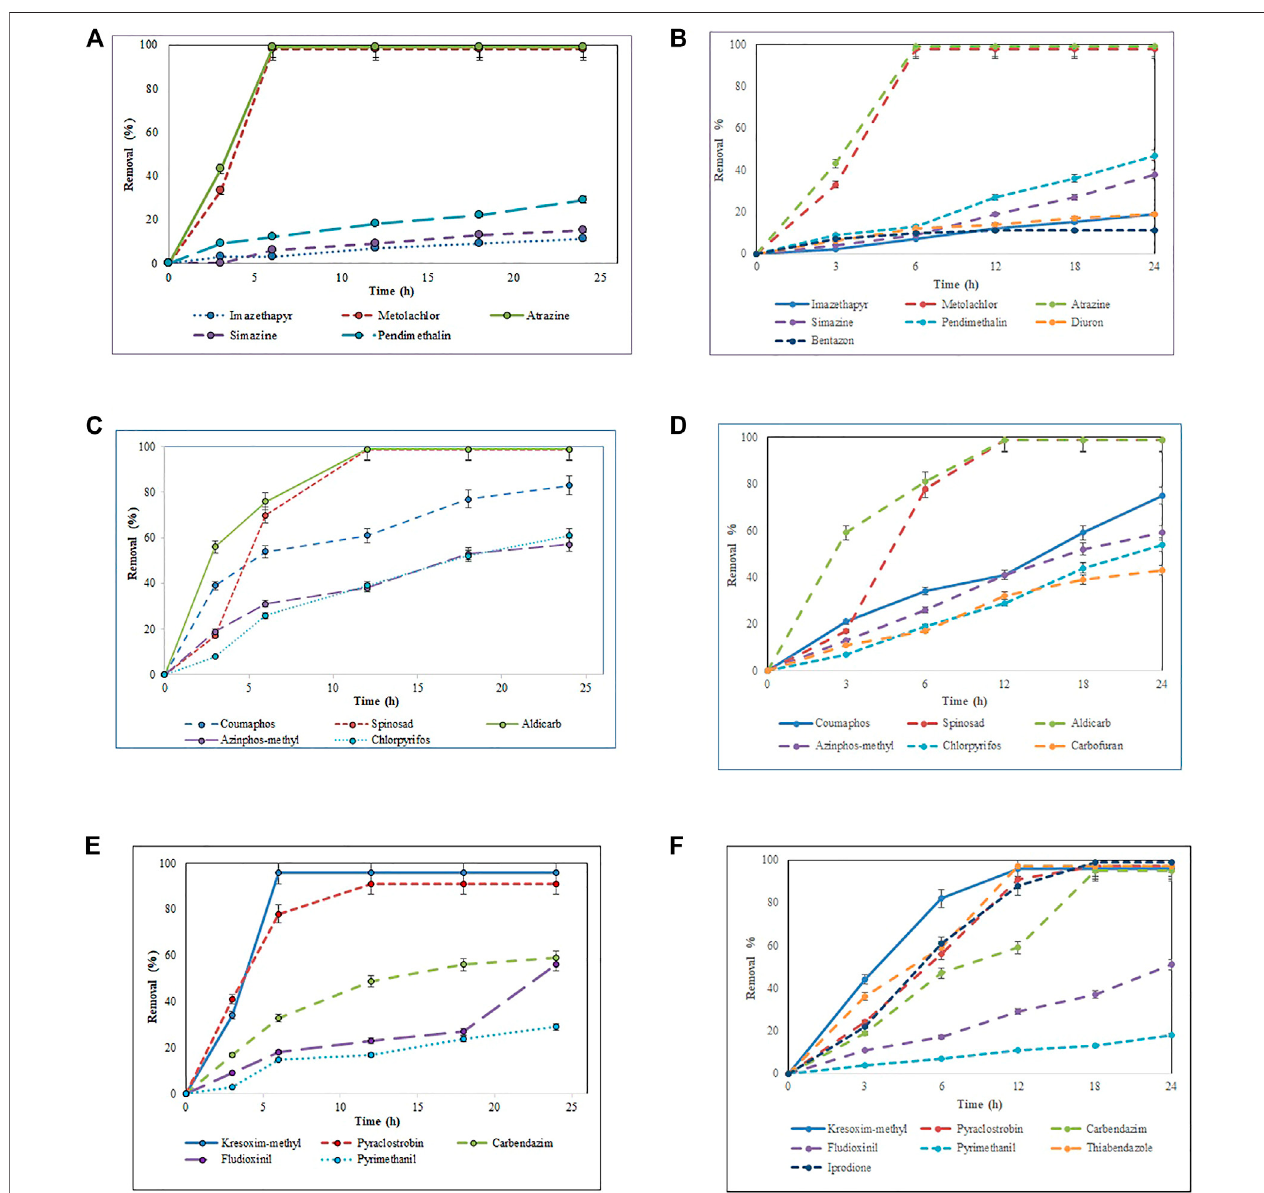
FIGURE 3 | Bio-catalytic removal of (A) 10 herbicides, (C) 10 insecticides, (E) nine fungicides treated separately in aqueous solution by Pleurotus dryinus laccase derived from BS and removal of (B) 10 herbicides, (D) 10 insecticides, (F) nine fungicides treated separately in aqueous solution by commercial laccase as a function of time. The experiments were done in triplicate at pH 7.0 and 20 ° C, and the error bar represents the percentage error at 5% level of signi fi